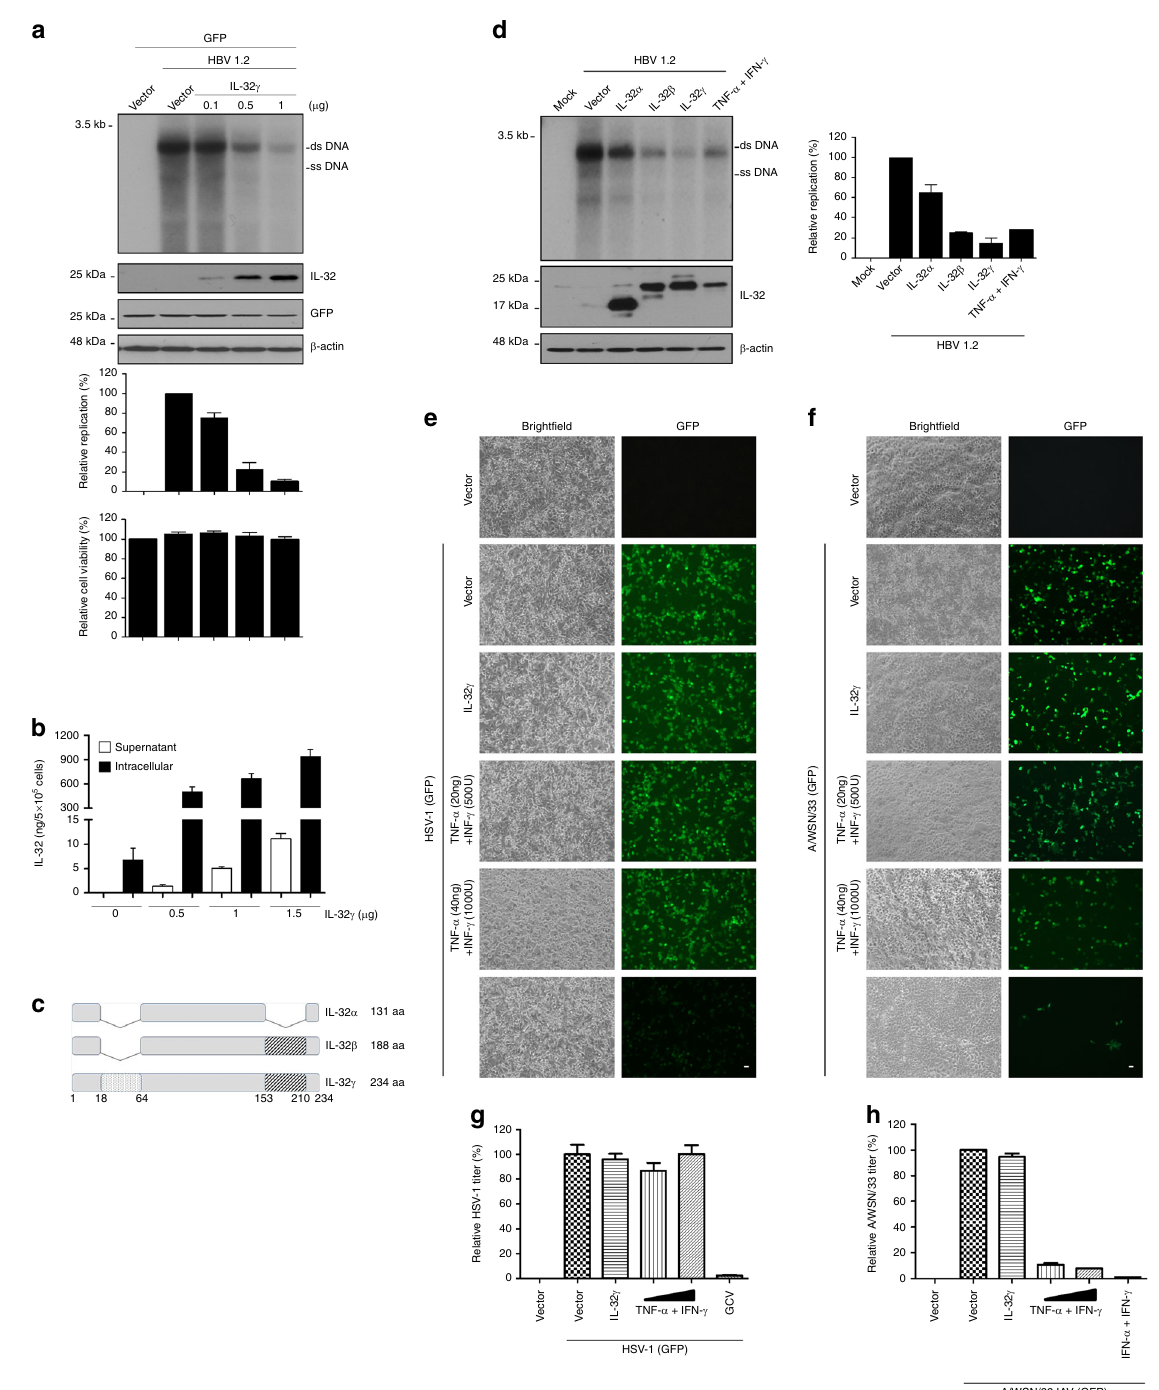
Fig. 2 Inhibition of HBV replication by IL-32 γ through an intracellular event and the effect of IL-32 γ on other viruses. a Vectors for HBV 1.2 and IL-32 γ were co-transfected into Huh7 cells. At 48 h post-transfection, viral replication, protein expression, and cell viability were analyzed by Southern blotting, western blotting, and XTT assay, respectively. b The levels of the IL-32 protein in culture medium and lysates of IL-32 γ -transfected Huh7 cells were measured by ELISA. c Schematic illustration of IL-32 isoforms. Shaded boxes represent the N-terminal and C-terminal extensions in IL-32 γ . d Vectors for HBV 1.2, IL-32 α , IL-32 β , or IL-32 γ were transfected in Huh7 cells as indicated. At 48 h post-transfection, viral replication and protein expression were analyzed by Southern and western blotting, respectively. Cells treated with cytokines were used as a control. e – h IL-32 expression vector or empty vector was transfected into Huh7 cells. After 16 h, cells were infected with herpes simplex virus 1 (HSV-1_GFP) or in fl uenza A virus (A/WSN/33_GFP) at 1 MOI. Cells were treated with the indicated concentrations cytokines (TNF- α and IFN- γ ). Treatment with GCV (1 μ g/mL) or IFNs (1000 U/mL IFN- α and 100 U/mL IFN- γ ) was used as a positive control for HSV-1 and A/WSN/33, respectively. The GFP signals were monitored at 24 h post-infection. Magni fi cation, ×100; scale bar, 100 μ m. Data ( a , b , d , g , h ) were obtained from three independent experiments (mean ±